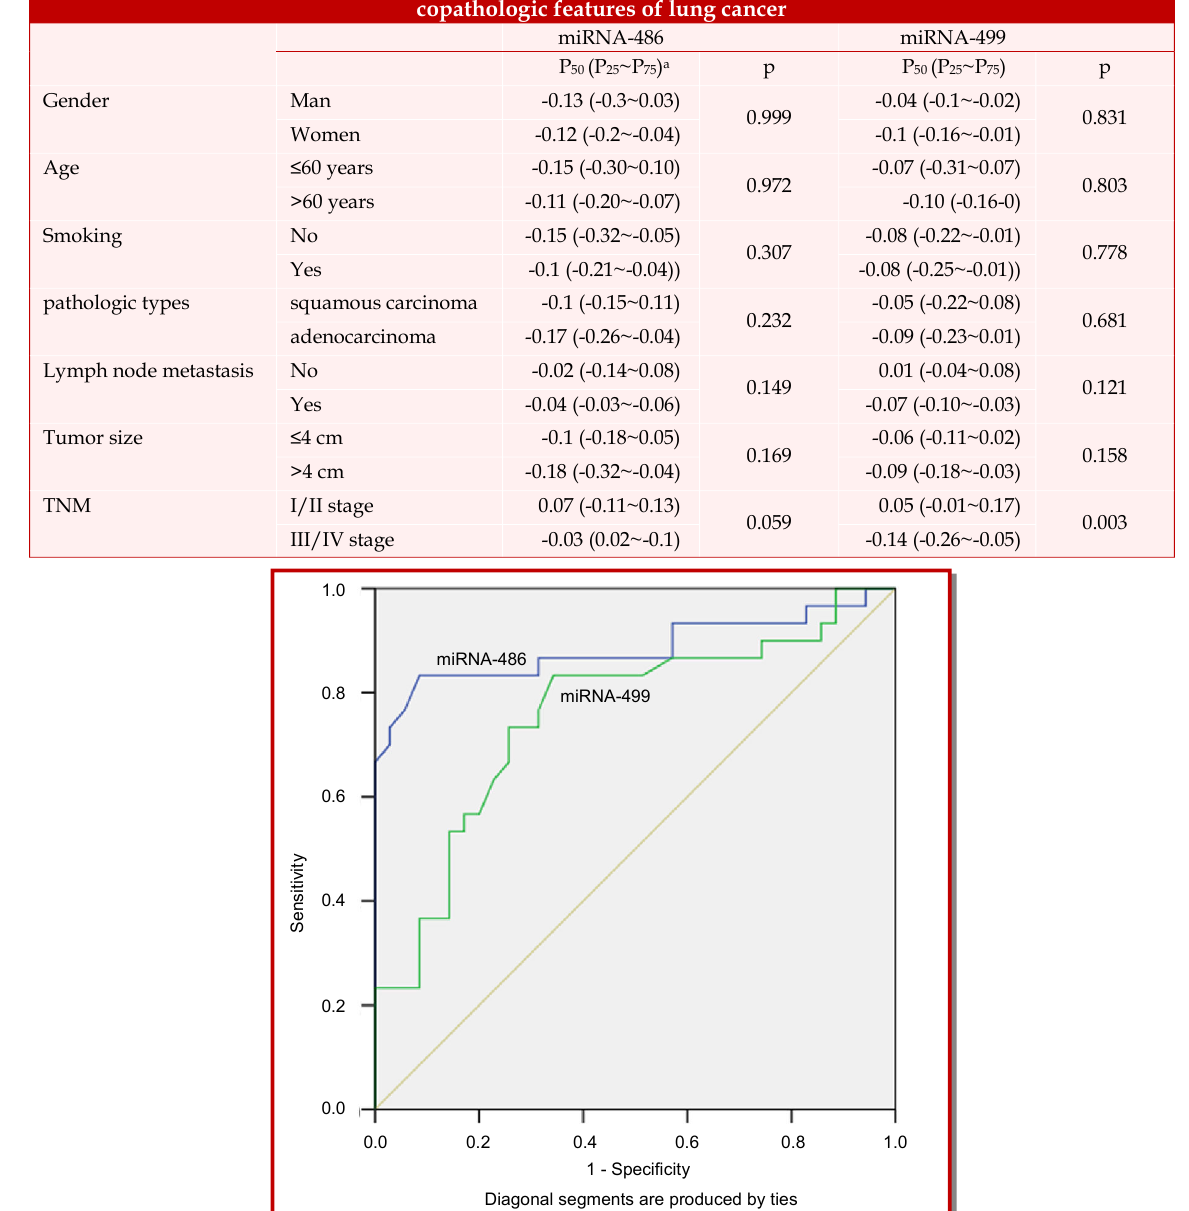
Figure 2: The evaluation of miR-486 and miR-499 on diagnosis of lung cancer by receiver operating characteristic curve. ROC curve of miR-486 and miR-499 for the diagnosis of lung cancer. The area under the ROC curve was 0.885 and 0.757 respectively (p<0.05). Diagonal segments are produced by